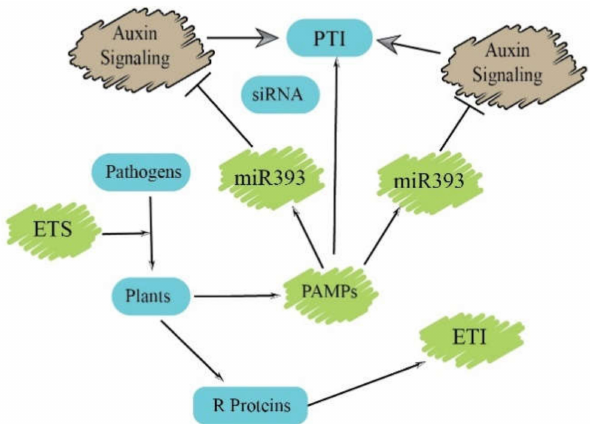
Figure 3. PAMP-triggered immunity (PTI) and effector-triggered immunity (ETI) regulated by small